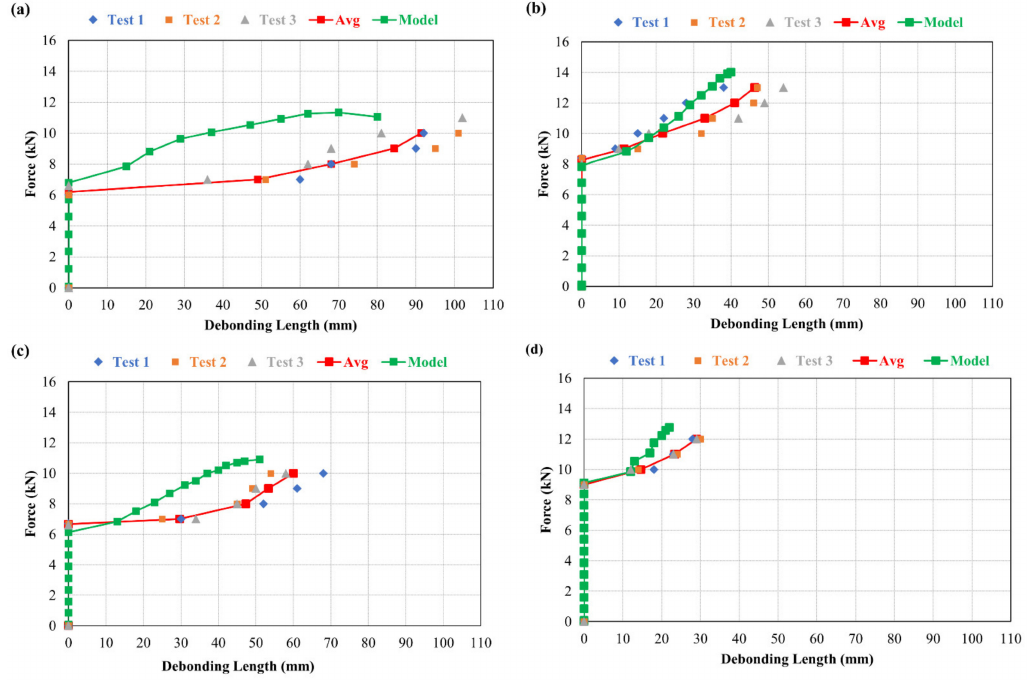
Figure 18. Force vs. debonding at interface in composite beam for; ( a ) M0R0F-M0R0F, ( b ) M0R0F- M0R30F, ( c ) M0R0F-M30R0F, and ( d ) M0R0F-M30R30F.